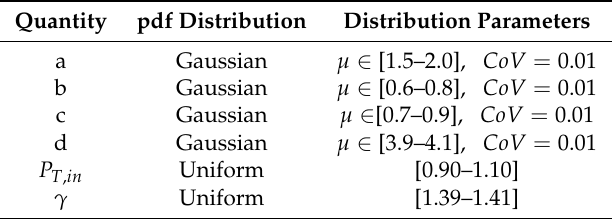
Table 1. Characteristics of the pdfs used to model the uncertain